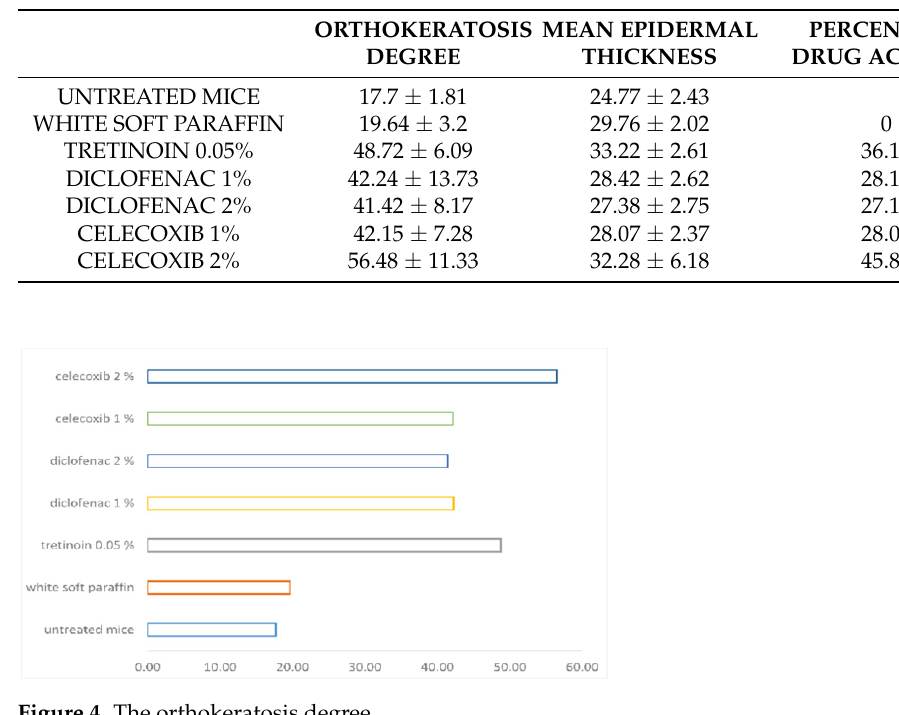
Figure 4. The orthokeratosis degree.